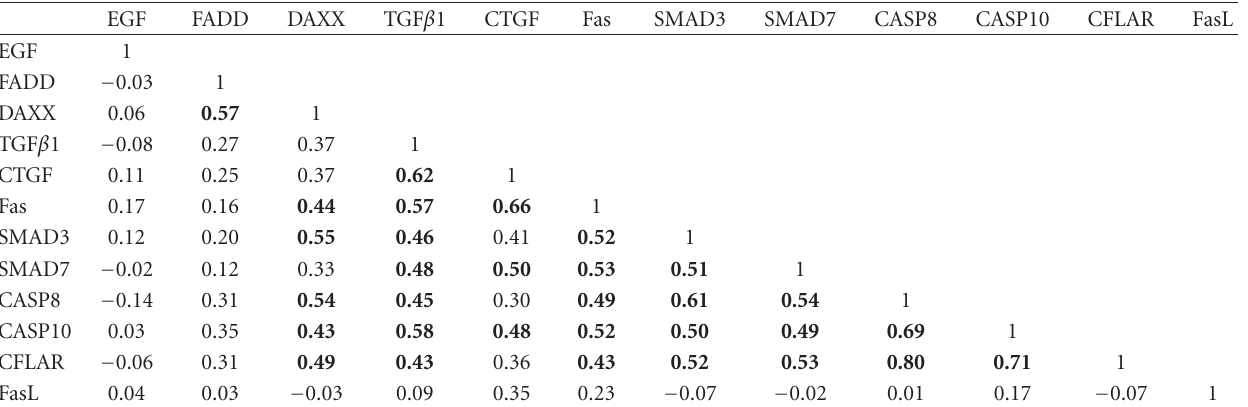
Table 1: Coexpression matrix for 12 Fas-related genes assayed by RT-PCR in 82 primary sarcomas. Correlation coe ffi cients in bold are significant at P ≤ 8 . 0 E − 05 using the Bonferroni adjustment for multiple